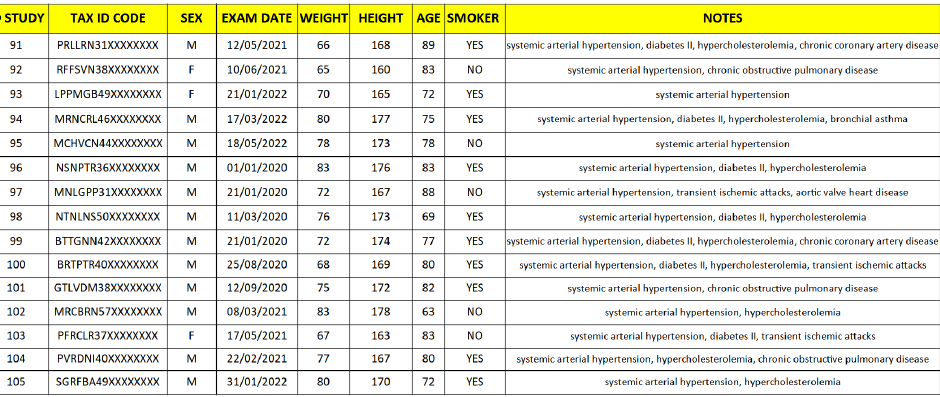
Figure 13. Data of the patients undergoing the